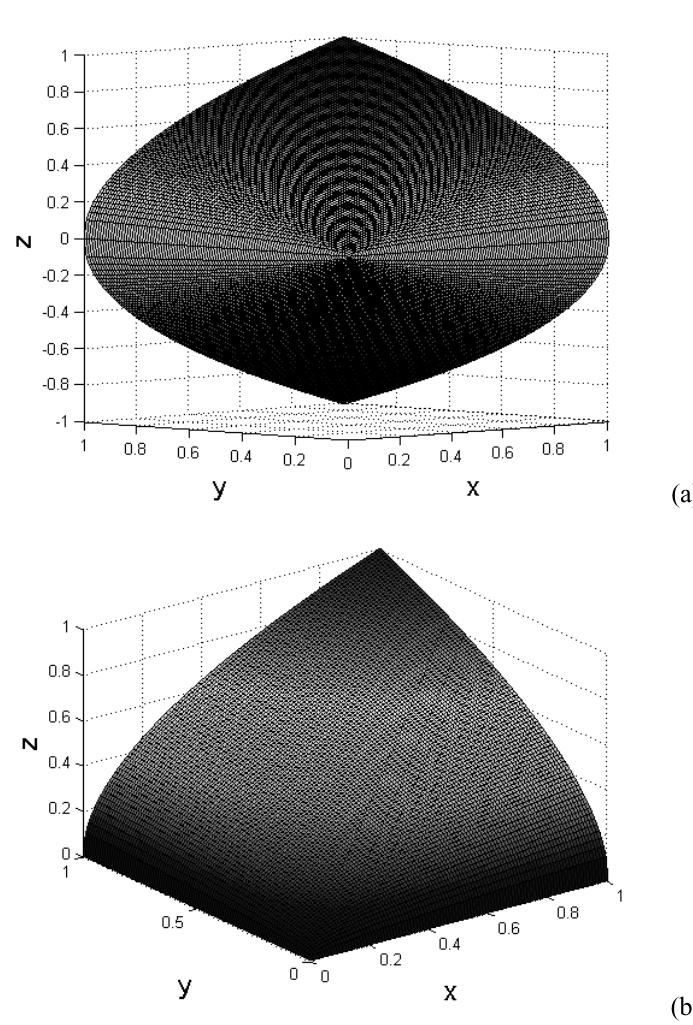
Fig. 6. Sample space for MRV strategy. (a) all the sample space and (b) sample space for z > 0.